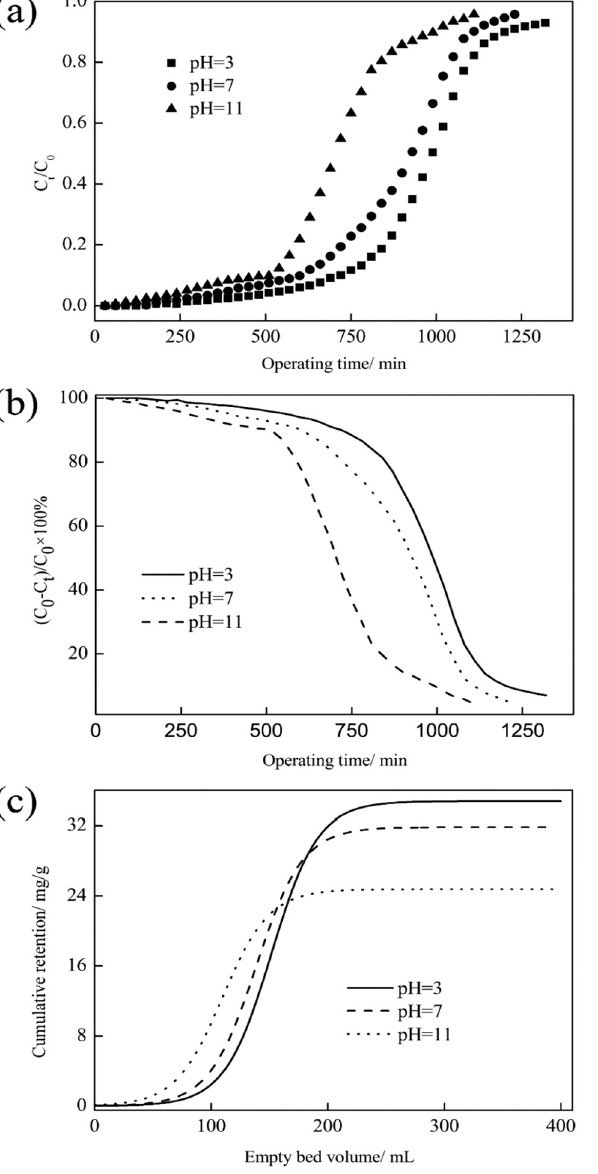
Figure 6: E ff ect of reaction temperature on the removal of ARG dye from aqueous solutions by fi xed - bed column packed with porous ceramsite. Initial pH was set at 3.0 and initial concentrationat 5mg/L. ( a ) BTCs, ( b ) RE, and ( c ) CRCs.